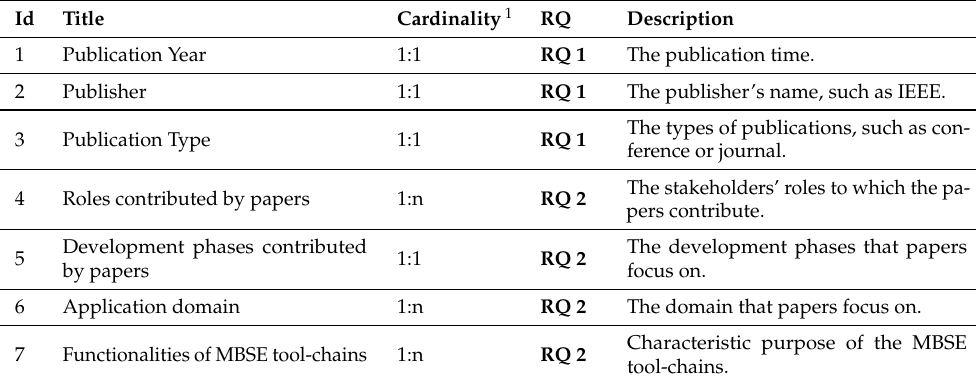
Table 1. Basic information about